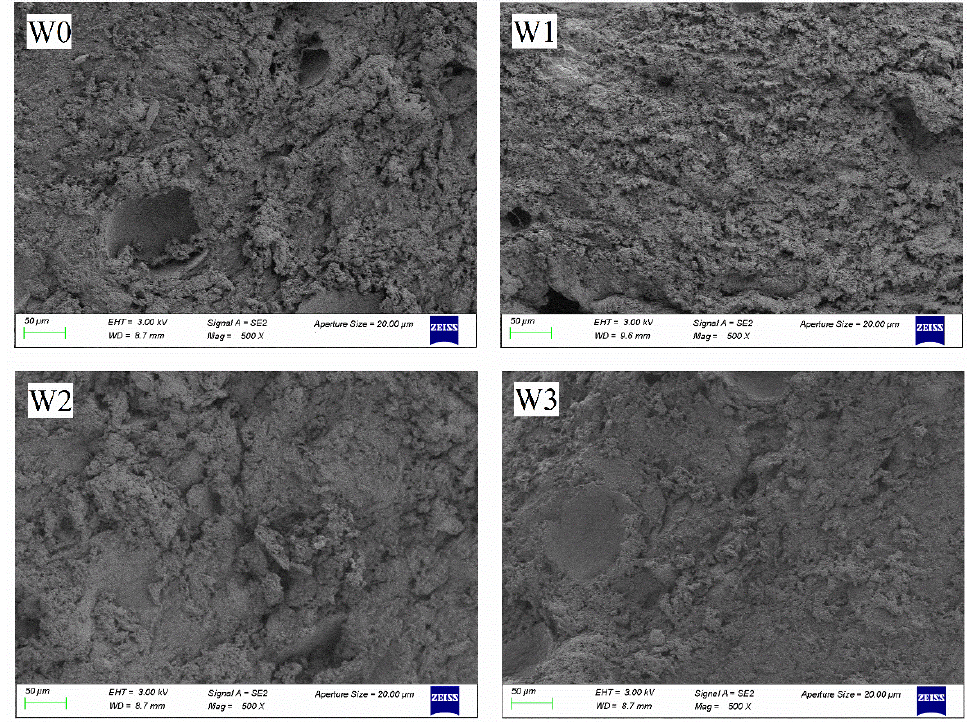
Figure 3. Microstructures (500× magnifications) of surimi gel with different washing times.